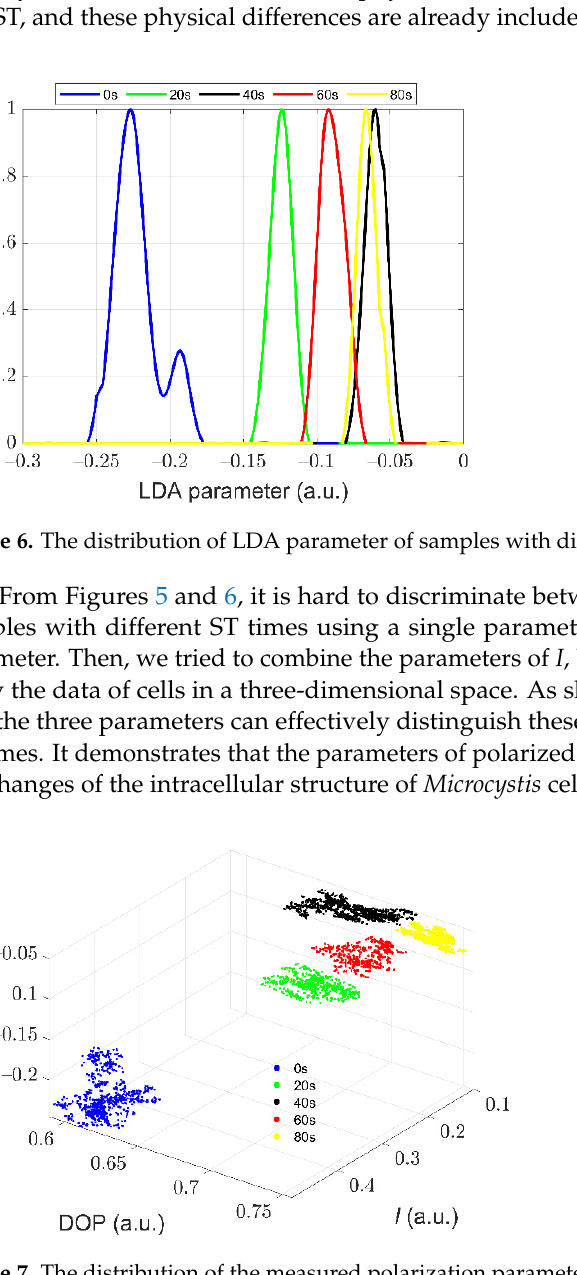
Figure 7. The distribution of the measured polarization parameters of Microcystis cells with different ST times.